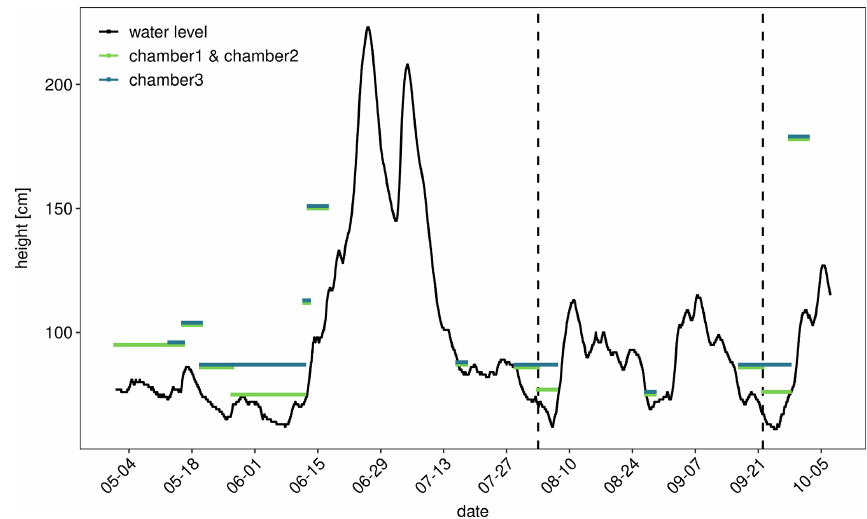
Figure 1. Water level of the Elbe River at gauge Magdeburg Strombrücke (13km downstream) in summer 2020. Colored lines indicate positioning of automatic flux chambers. For example a horizontal line at 95cm means that a particular chamber was located at the water line when the gauge recorded a water level of 95cm. Vertical dotted lines indicate intensive sampling